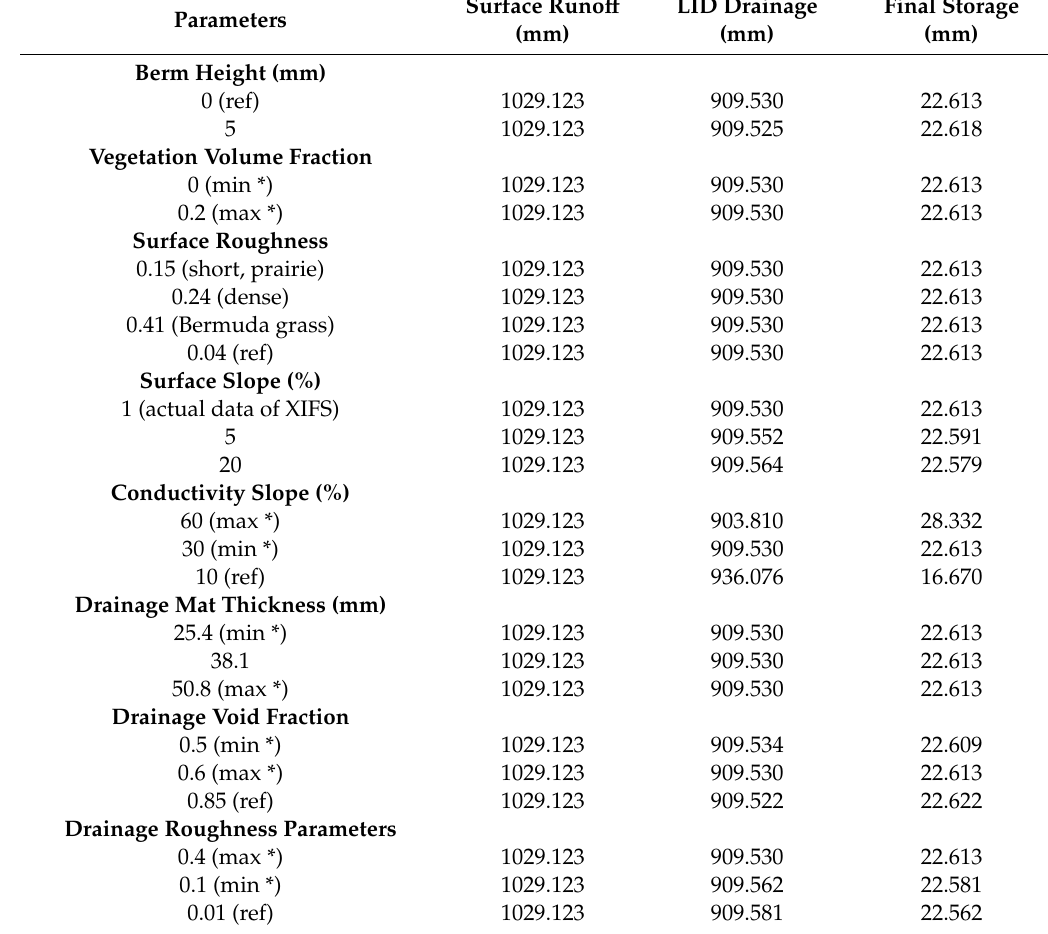
Table 1. The test results of insensitive parameters in the GRS model.